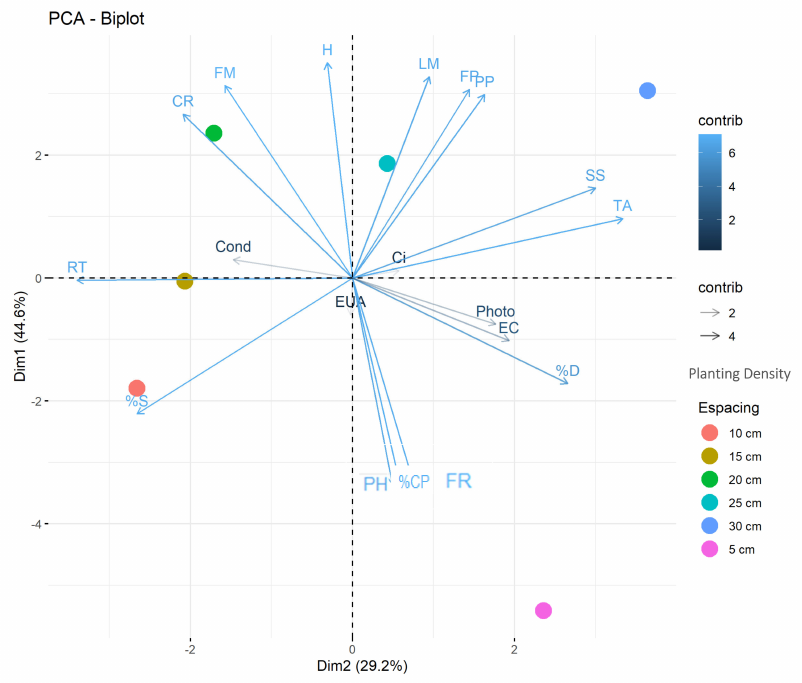
Figure 11. Analysis of the main components among the variables obtained in the spacing experi- ment for the cultivar “Pirncinque” evaluated in Lages-SC, Brazil in the 2018/2019 and 2019/2020 harvests. Caption: FP = fruits per plant. PP = production per plant. PH = productivity per hectare. FM = fresh mass. %CP = commercial percentage. %S= small fruits percentage. %D=discard percentage. LM = epidermis luminosity. CR = epidermis Chroma. H = epidermis hue angle. FR = firmness. SS = total soluble solids. TA = titratable acidity. RT = soluble solids/titratable acidity ratio. Cond = stomatal conductance. Ci = intercellular concentration. EU = water-use efficiency. EC = carboxylation